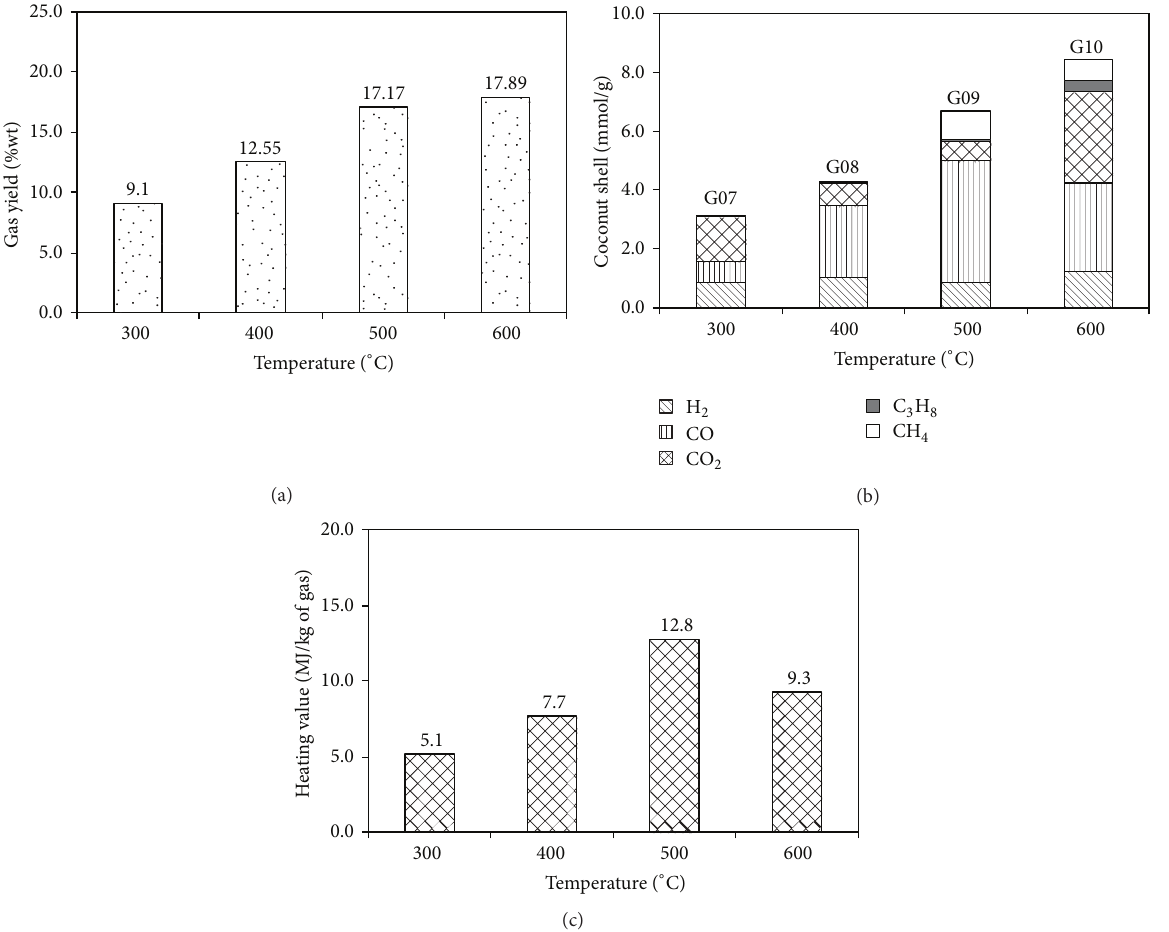
Figure 3: Effect of temperature on (a) gas yield, (b) composition, and (c) heating value of gas products from CO 2 gasification of coconut shell for 180min and chemical ratio of